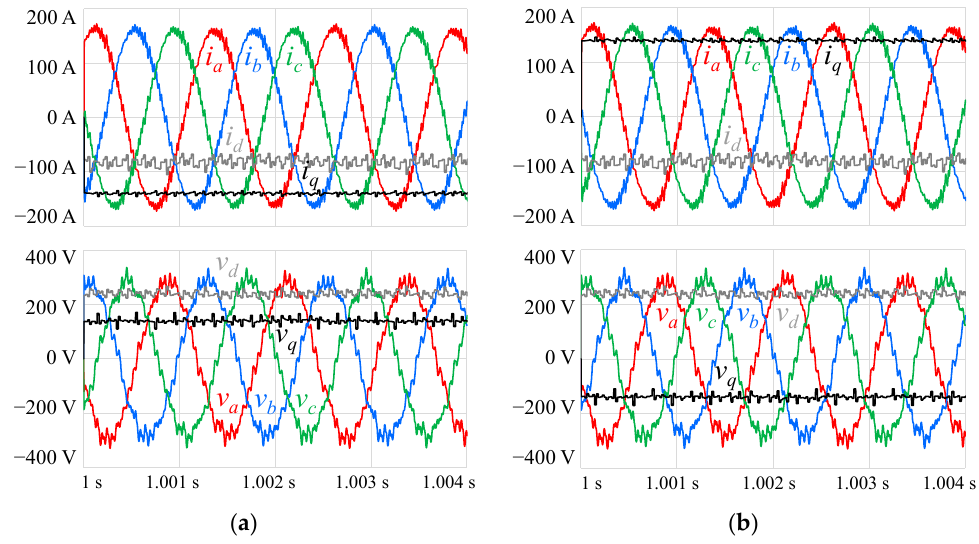
Figure 5. Simulation results of the stator windings voltages ( v a , v b , v c , v d , v q ) and currents ( i a , i b , i c , i d , i q ), applying Park’s transform with the electric machine operating as a generator at nominal speed (12 krpm), coupled with a − 50 Nm load, rotating in the directions conventionalized as ( a ) positive and ( b ) negative.